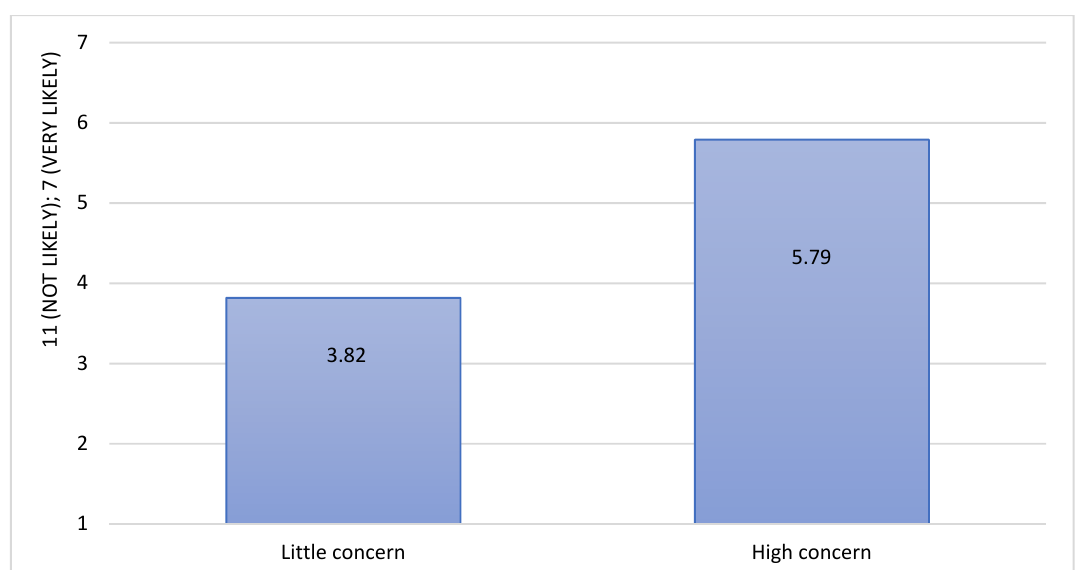
Figure 13. Probability of adopting agroecological practices in the future depending on the degree of information regarding the agrochemicals.